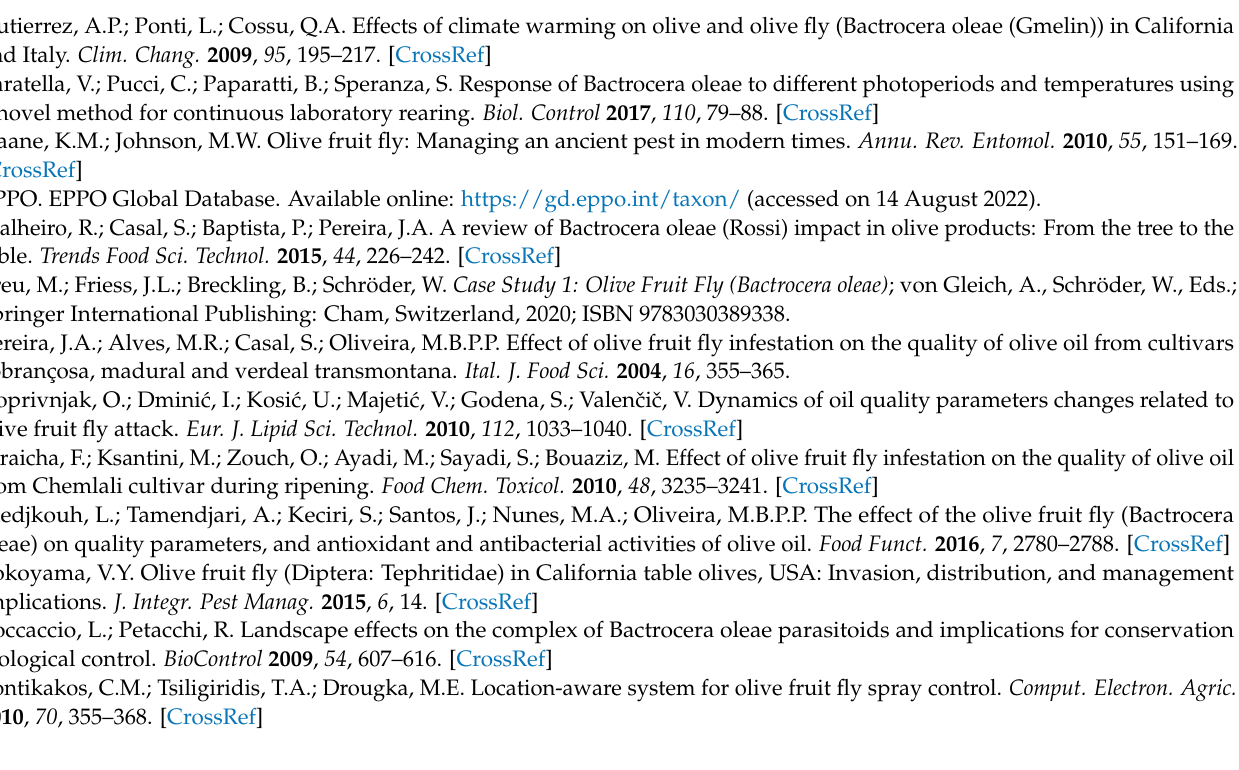
10.3390/agronomy12102298/s1, Figure S1: Best fit fertility rate function (9) and experimental data from Preu et al. [6]. Figure S2: Best fit mortality rate function (7) for eggs and experimental data from Preu et al. [6]. Figure S3: Best fit mortality rate function (7) for larvae and experimental data from Preu et al. [6]. Figure S4: Best fit mortality rate function (7) for pupae and experimental data from Preu et al. [6]. Figure S5: Best fit mortality rate function (7) for adults and experimental data from Preu et al.